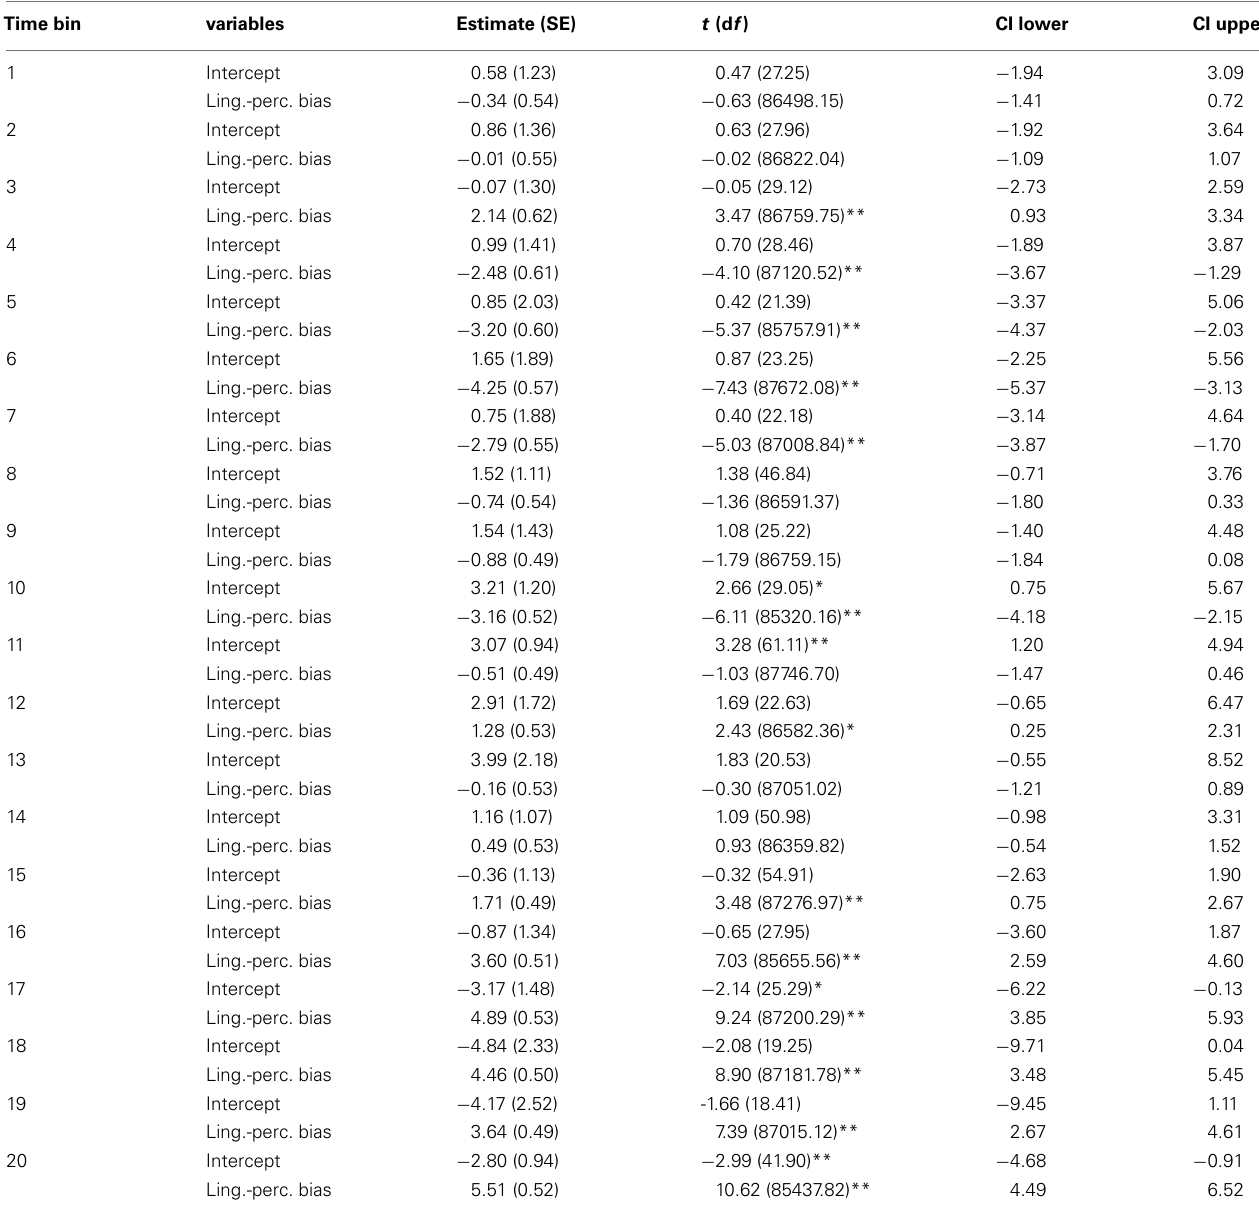
Table 3 | Regression coefficients iconicity judgment EEG